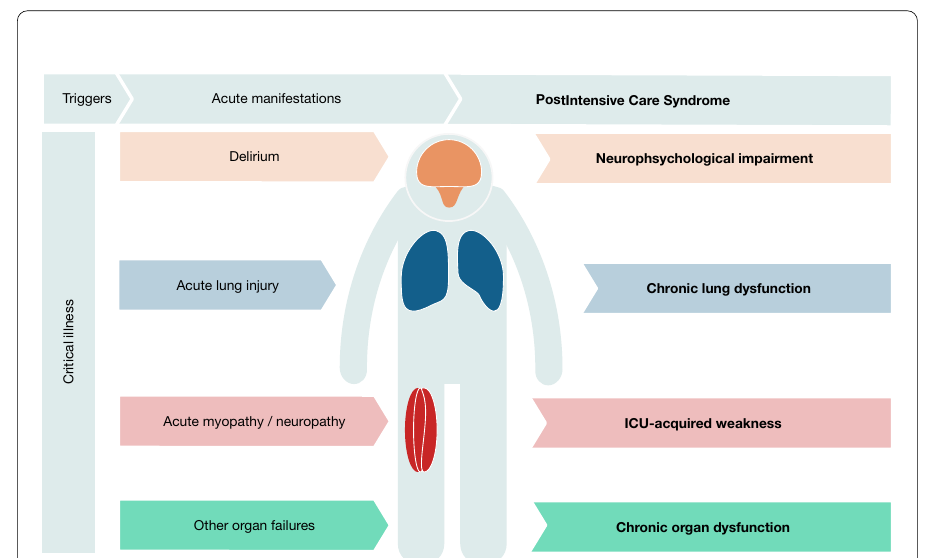
Fig. 1 Spectrum of postintensive care syndrome. Many of the long‑term conditions that constitute the postintensive care syndrome have been related to specific syndromes that appear during acute care. However, it is not known if this relationship reflects a common primary cause, a pathogenetic association or simply an association due to underlying